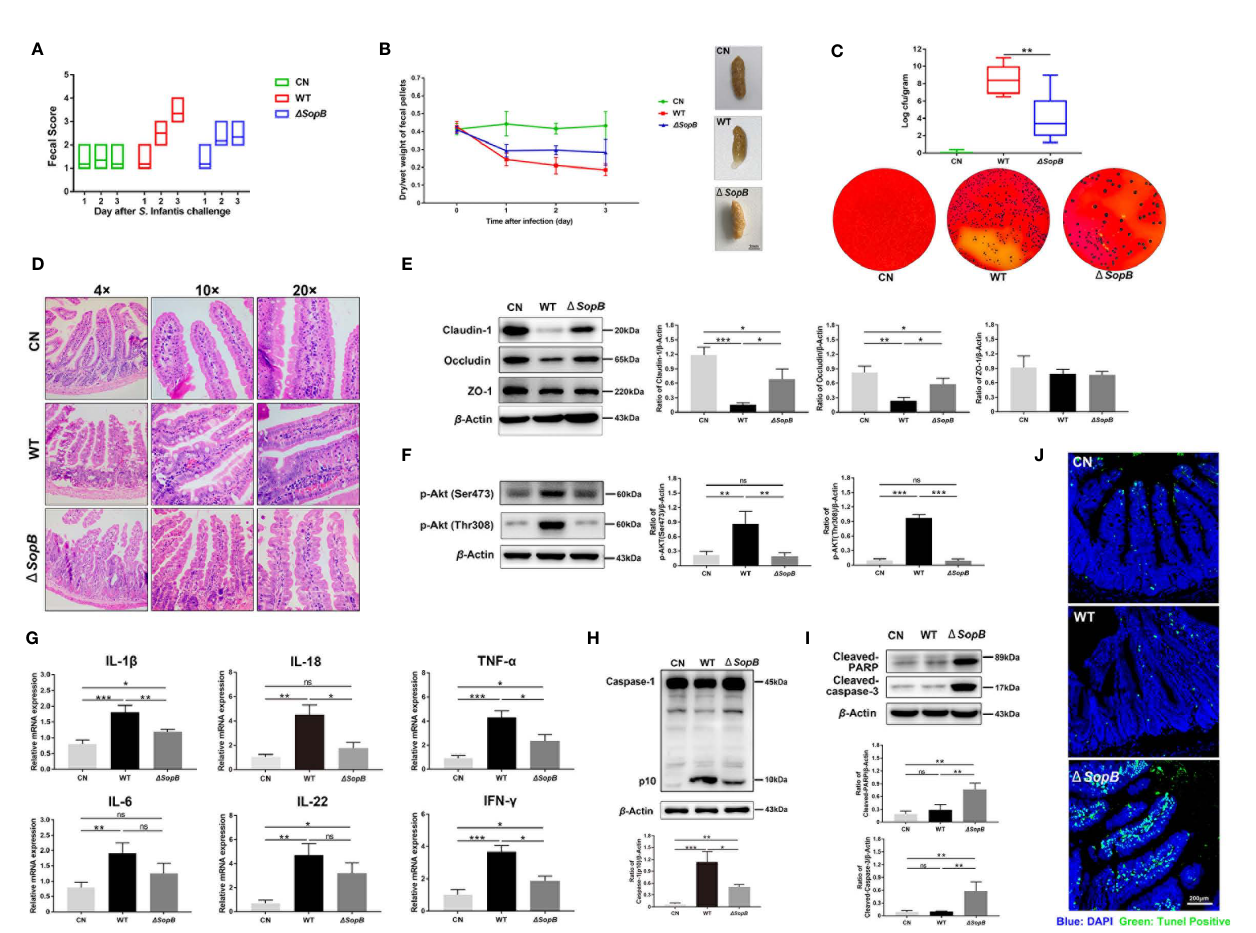
FIGURE 6 | WT S . Infantis caused more severe intestinal in fl ammatory damage to the C57BL/6 mice gut than the D SopB mutant. (A) The fecal score curve of mice in three groups after Salmonella infection. The fecal status of mice was scored daily. (B) Results of the dry/wet weight ratio offeces. The starting day of the experiment was considered as day 0 (24 h after streptomycin gavage). Three representative feces images of each group are shown on the right side of the curve. (C) Quanti fi cation offecal bacterial burdens on day 3. Three representative plots of bacterial colonies images in each group are below the curve. (D) Ileum representative photomicrographs of sections stained with H&E. (E, F) Western blot analysis of Claudin-1, Occludin, p-Akt (Ser473), and p-Akt (Thr308) protein levels of three groups. (G) Expression of IL-1 b , IL-18, IL-6, IL-22, TNF- a , and IFN- g mRNA in ileal tissues. (H, I) Western blot analysis of Caspase-1, Cleaved-caspase-3, and Cleaved-PARP protein levels of three groups. (J) The representative images of TUNEL fl uorescence staining in ileum tissue pathological sections. Blue: DAPI; Green: TUNEL positive cells. Data were presented as mean ± SEM. (n = 6). Data were presented as the mean ± SEM from three independent experiments (n = 3). * P < 0.05, ** P < 0.01, *** P < 0.001. CN, control. ns, no signi fi cant